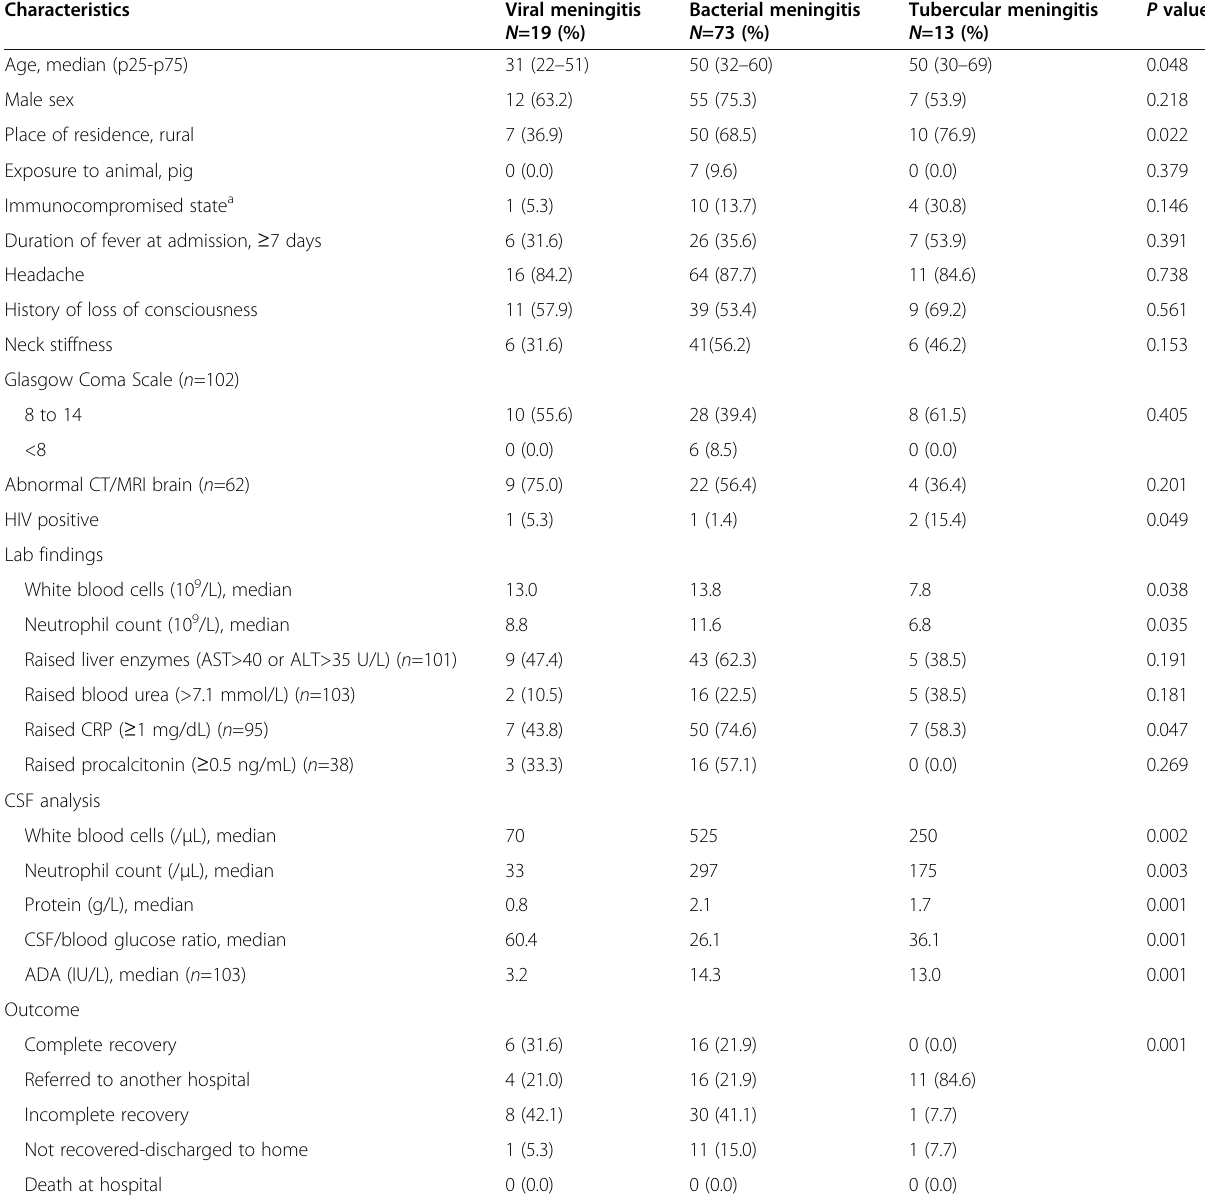
Table 3 Demographic and clinical characteristics of viral, bacterial, and tubercular meningitis